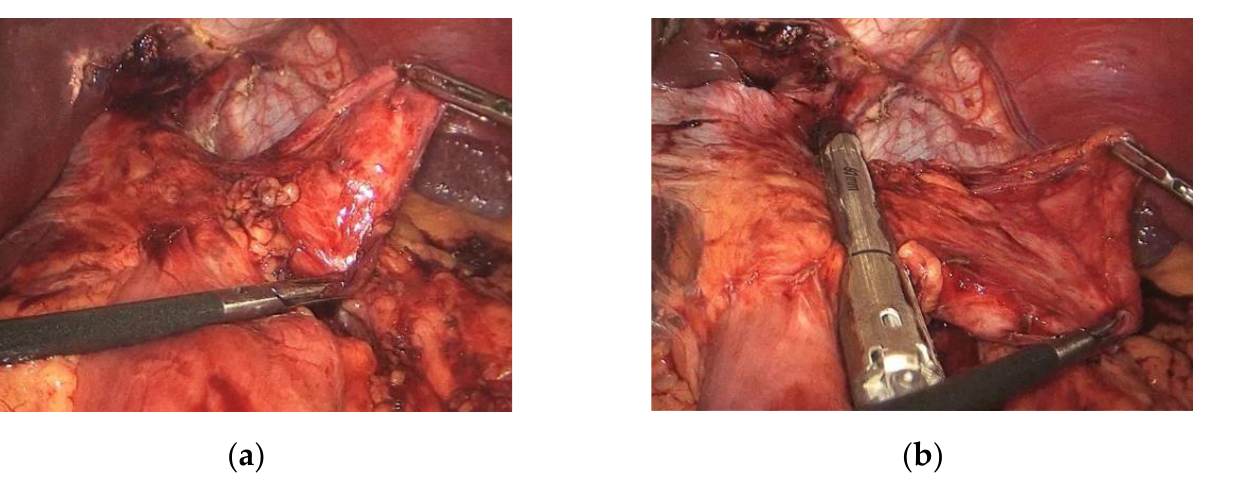
Figure 1. ( a ) Complete liberation of the dilated gastric pouch. ( b ) The gastric pouch was then recalibrated using a linear mechanical stapler, removing the dilated lateral part of the pouch from the gastrojejunal anastomosis to the gastroesophageal junction.